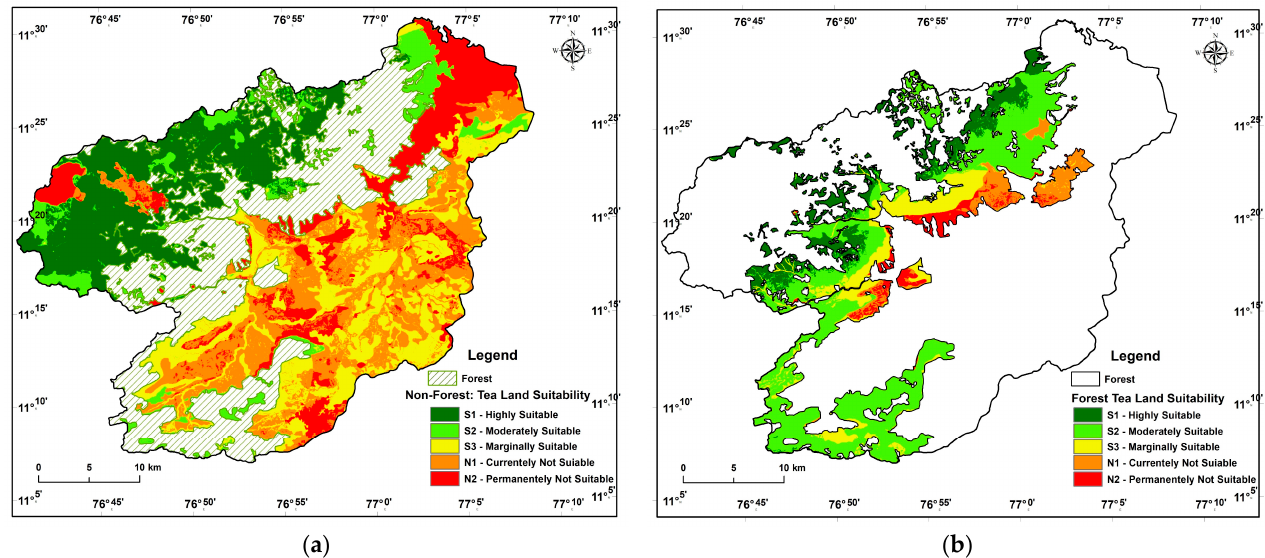
Figure 8. Land suitability for tea plantations under ( a ) non-forest areas and ( b ) forest areas.